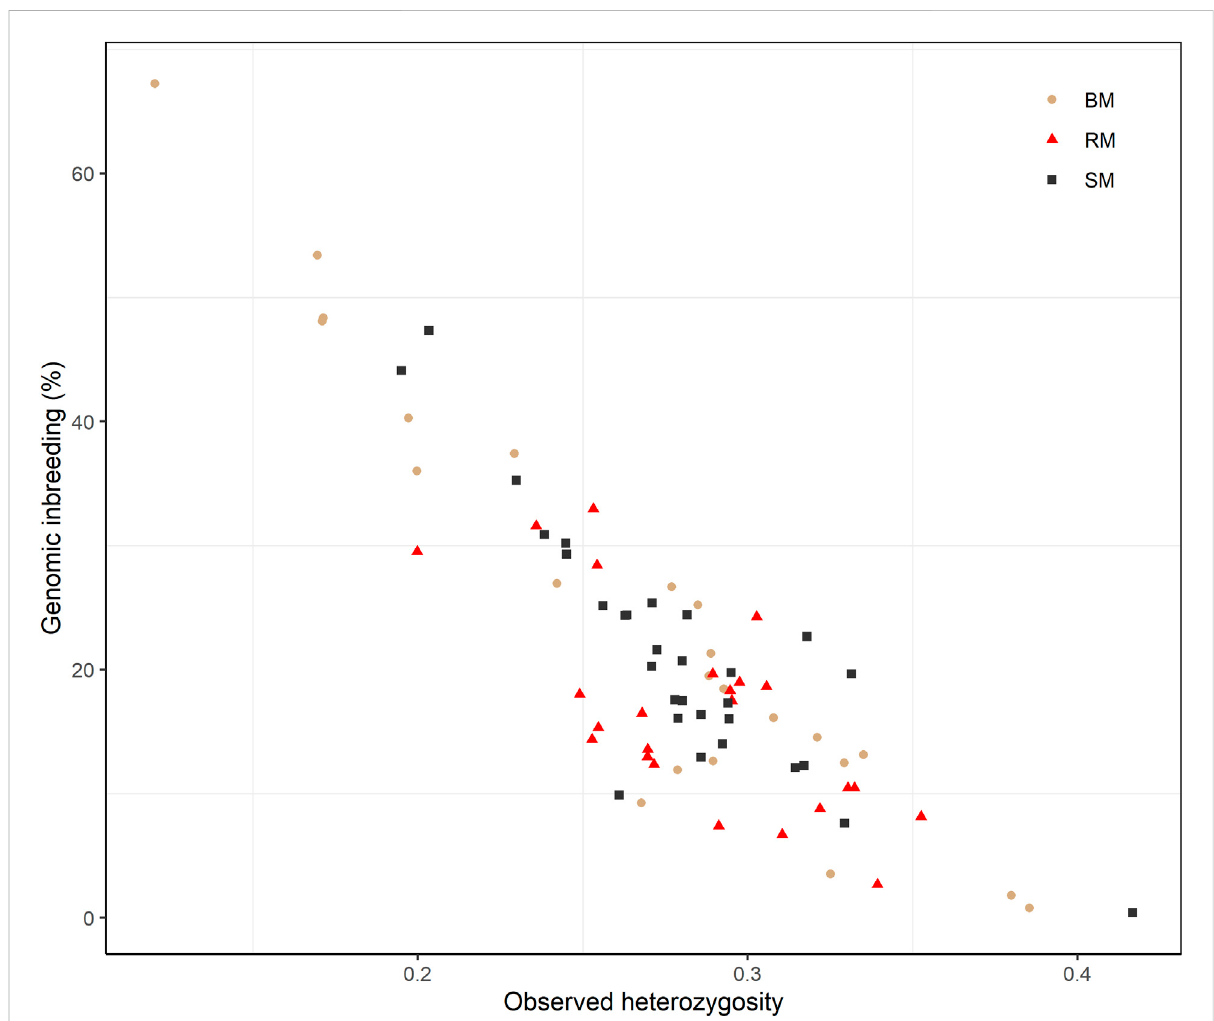
FIGURE 5 Scatterplotofthecorrelationbetweenobservedheterozygosityandgenomicinbreeding(FROH)forBlond,RedandSwallow-belliedMangalitsa pigs. The Pearson correlation coef fi cient was signi fi cant across breeds (r = 0.88; p-value <